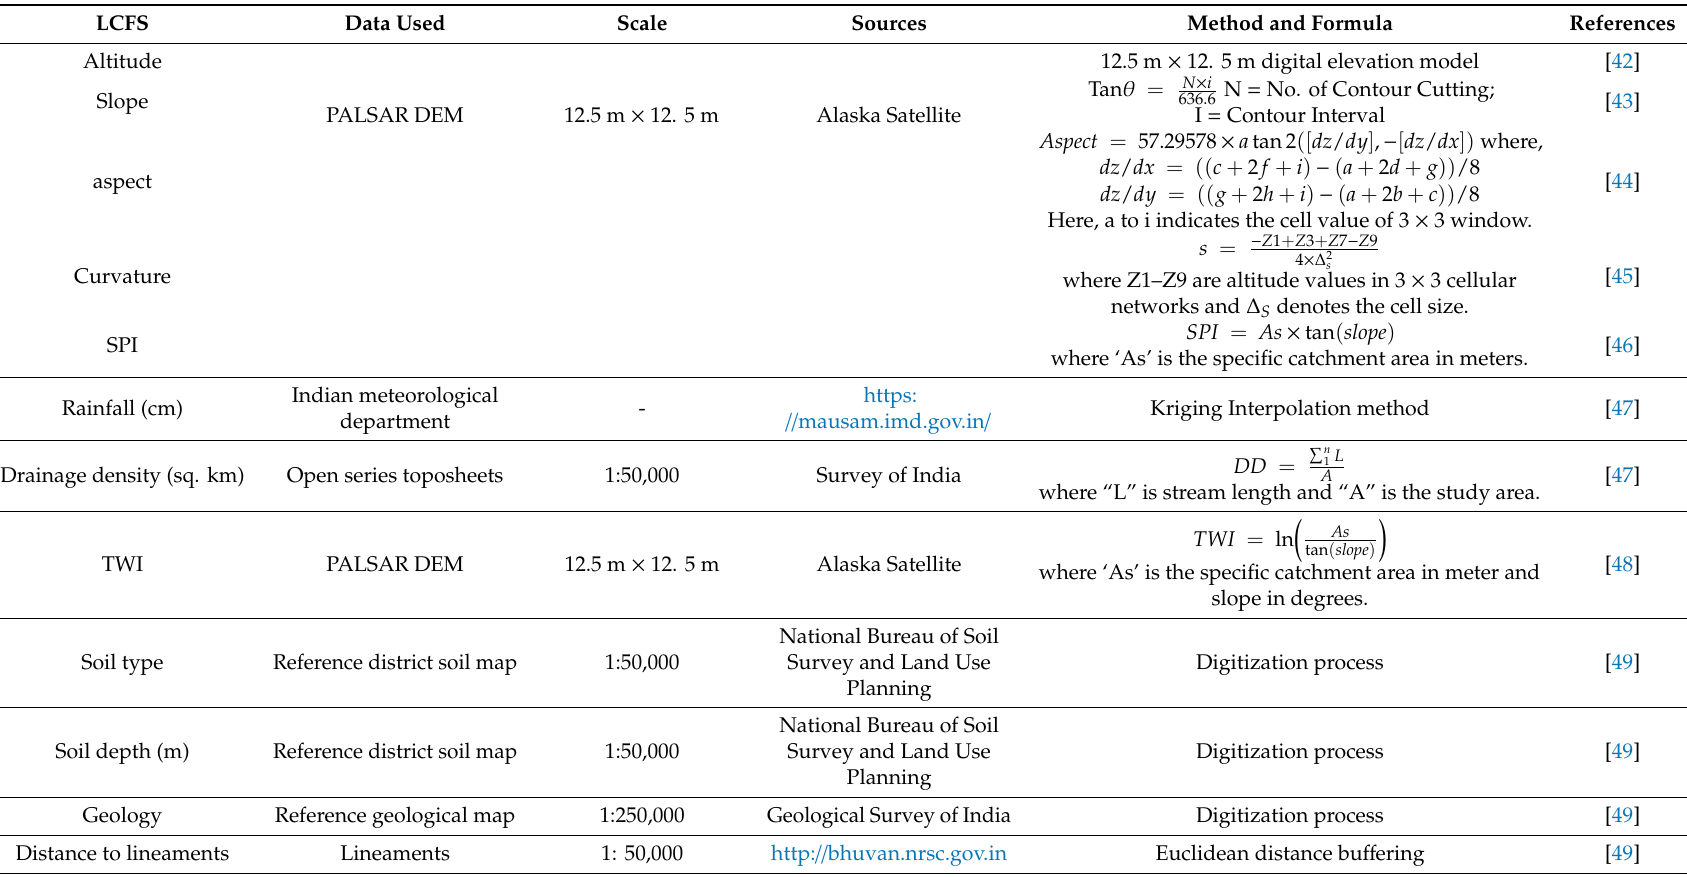
Table 1. Landslide conditioning factors (LCFs), detailed of data used and their respective